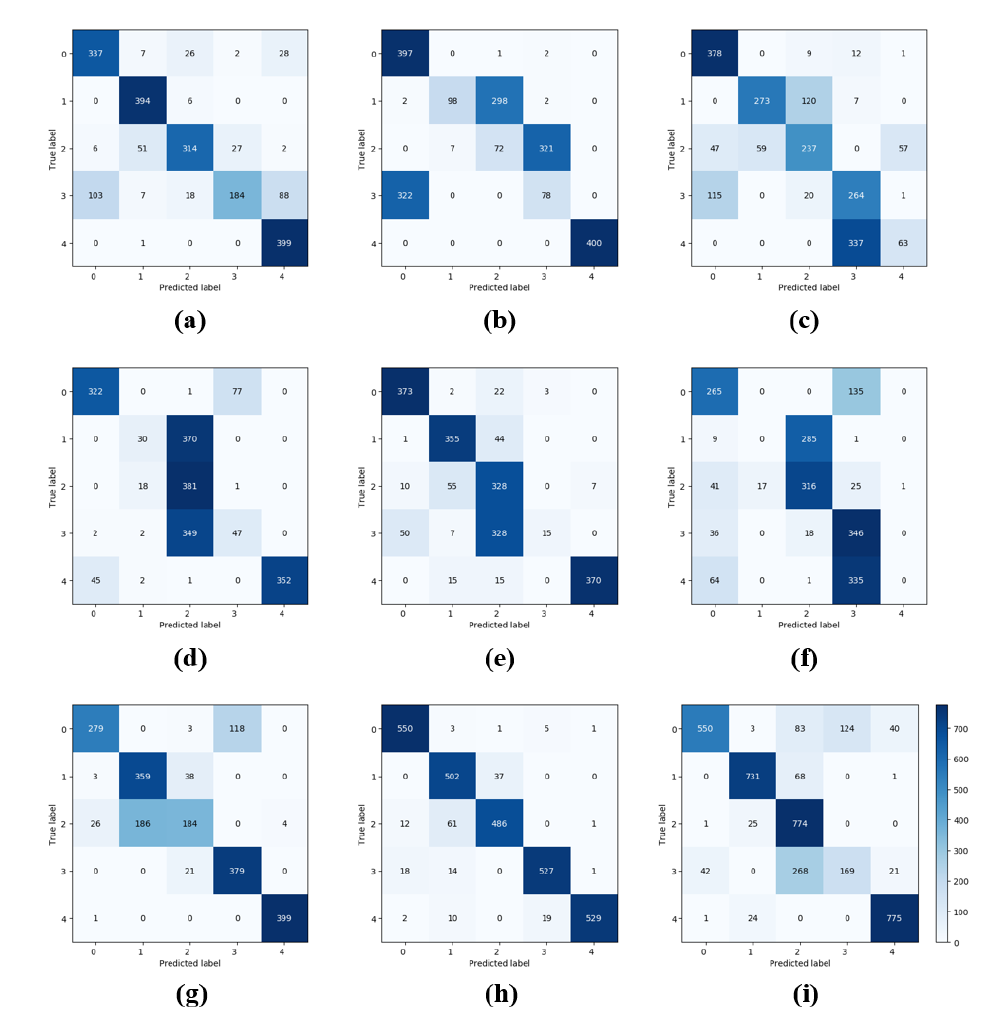
Figure 6. F1-score of each land cover class in experiments of transferability analysis.